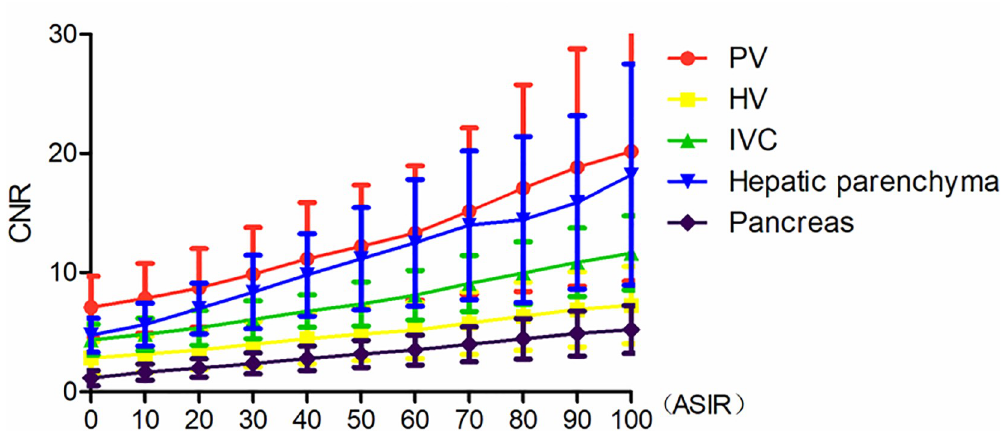
Fig 2. CNR values in the PV trunk, HV, IVC, hepatic parenchyma, and pancreas at 60keV. As the weight value of ASIR increased, the CNR value gradually